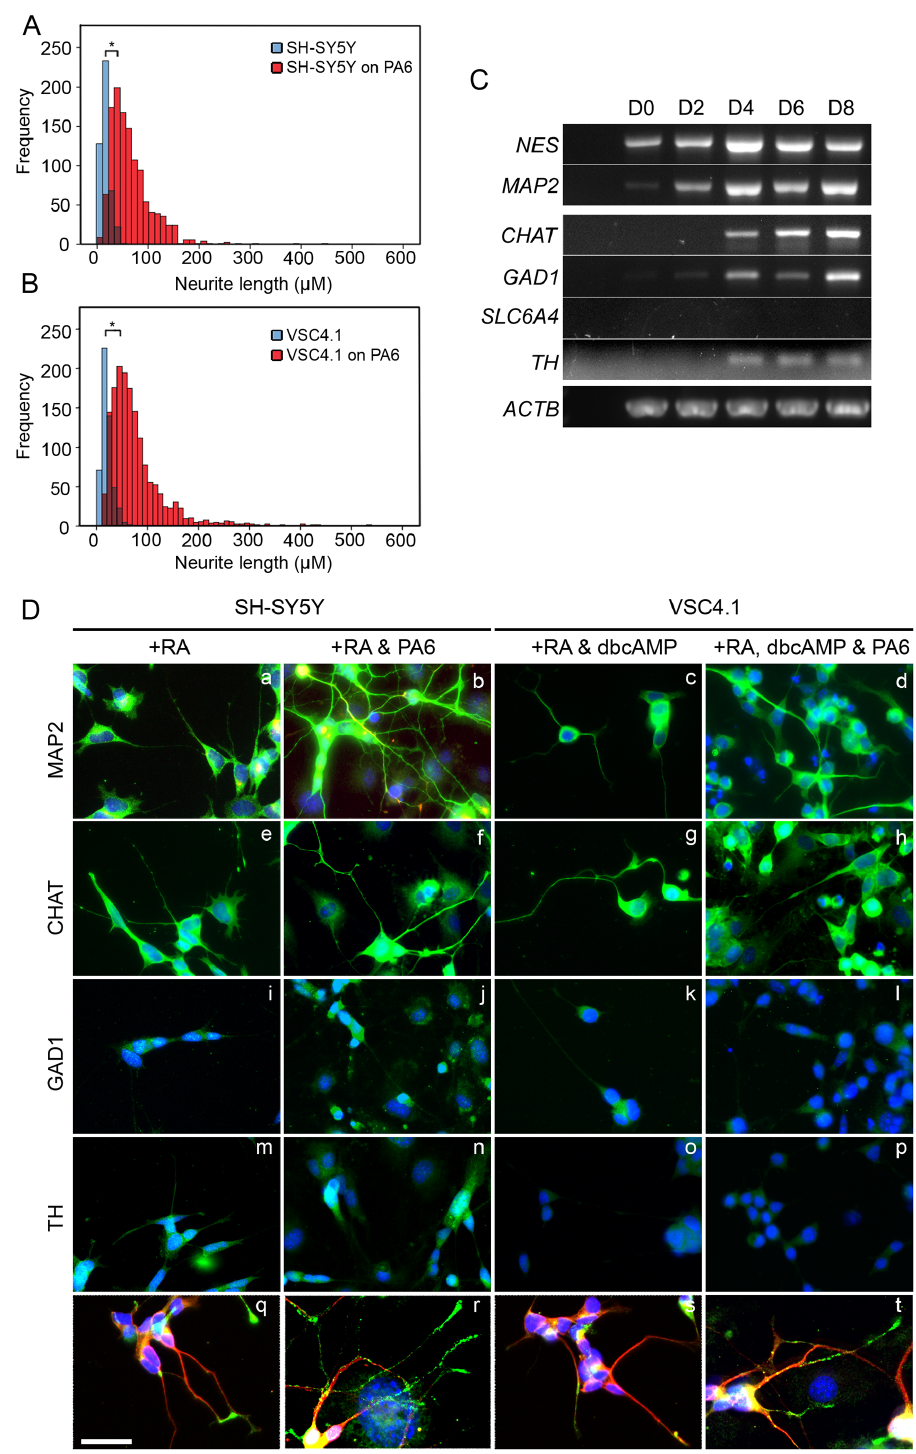
Fig 5. Characterisation of SH-SY5Y and VSC4.1 differentiated on PA6 under optimised conditions. (A) Differentiation of VSC4.1 on PA6 with 0.5 μ M RA and 1mM dbcAMP (VSC4.1 on PA6) results in neurites which are significantly longer and more numerous than VSC4.1 differentiated with 1mM dbcAMP alone (VSC4.1 alone). (B) Similarly, differentiation of SY5Y in the presence of PA6 and 10uM RA (SY5Y on PA6) results in neurites which are significantly longer and more numerous than those present when differentiated with